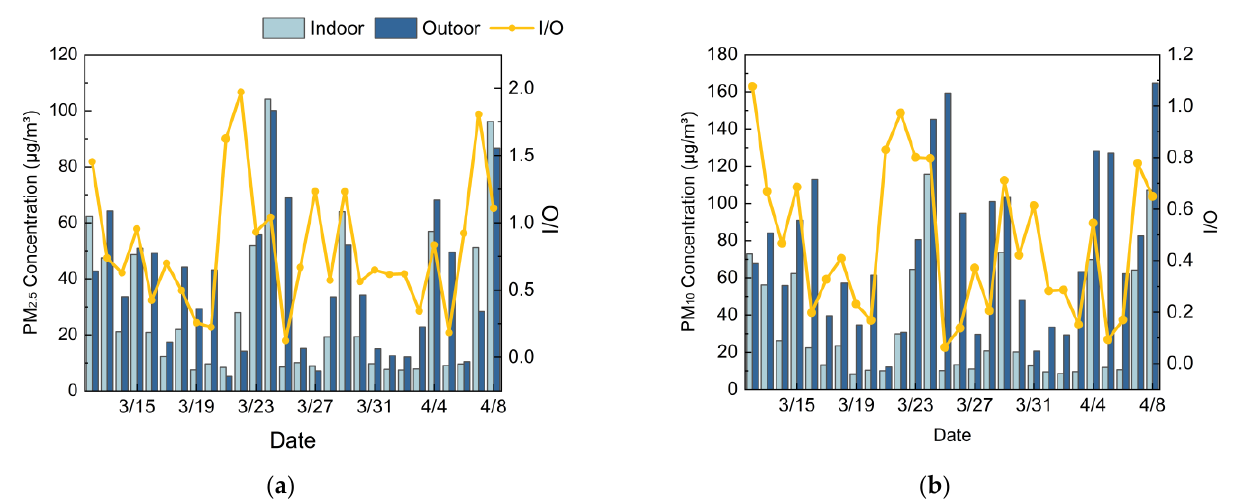
Figure 15. Comparison between indoor and outdoor PM concentrations: ( a ) PM 2.5 ; ( b ) PM 10